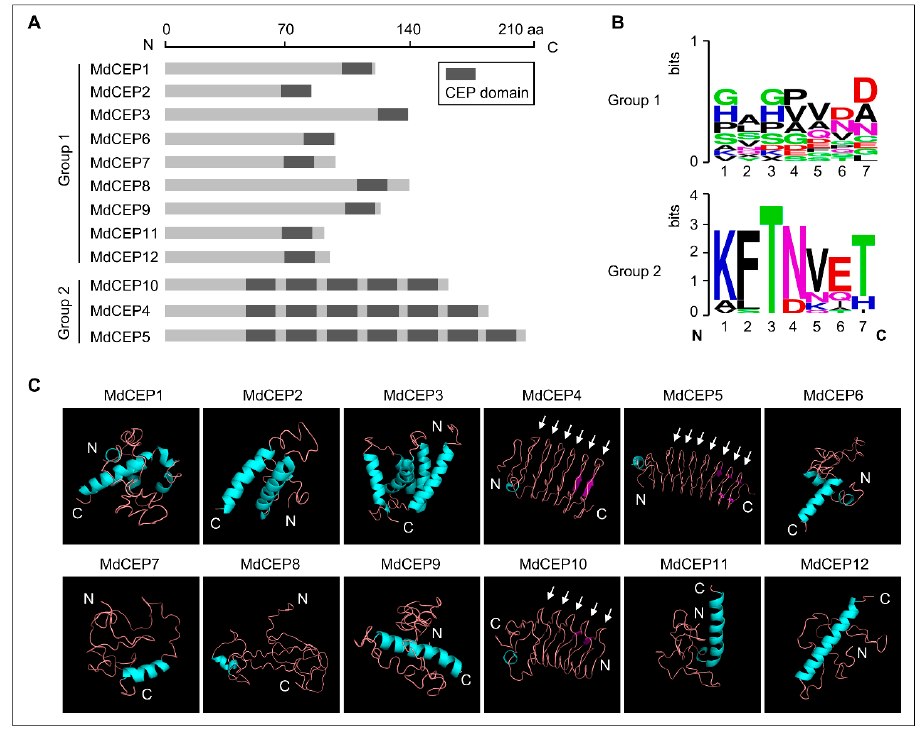
Figure 5. MdCEPs are divided into 2 subgroups according to the number of CEP domains. ( A ) Schematic representation of MdCEP family members. Group 1 contains members with one CEP domain; Group 2 contains five-seven CEP domains. The dark grey boxes represent CEP domains. ( B ) A WebLogo representation of the sequence before CEP domains (Group 1) and adjoining sequence between CEP domains (Group 2). ( C ) Three-dimensional structures of MdCEPs predicted by I-TASSER website. The CEP domains in Group 2 are pointed by arrows.